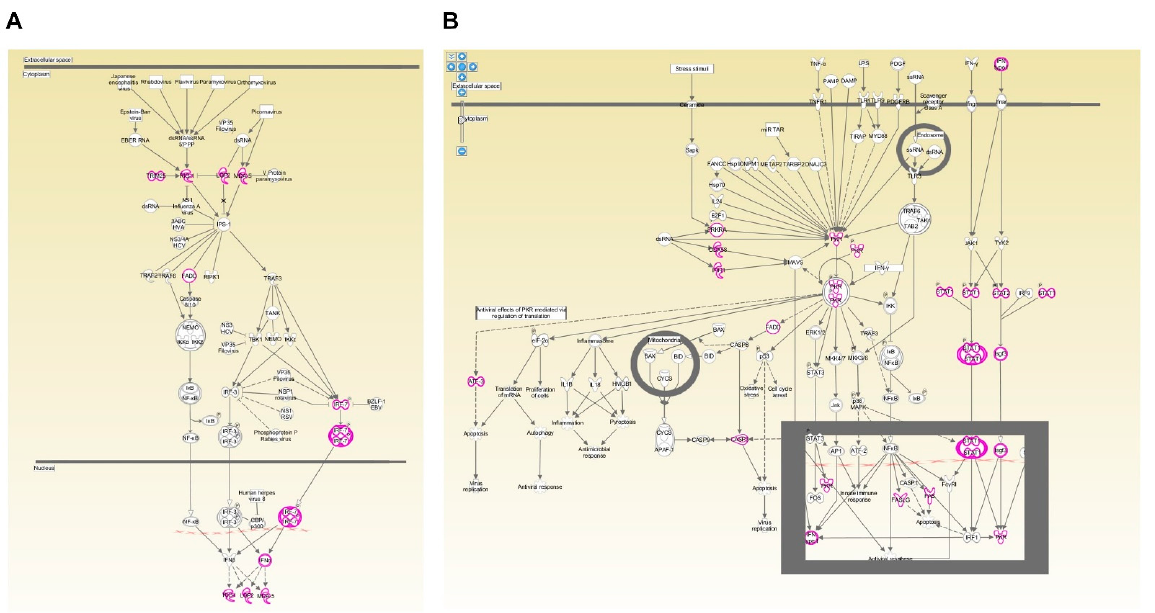
Figure A5. Canonical pathways identified by functional analysis on IPA. Two canonical pathways associated with DEGs upregulated upon I-TBEV treatment are shown: “Role of RLRs in antiviral innate immunity” ( A ) and “Role of PKR in interferon induction and antiviral response” ( B ). DEGs identified by the RNA-Seq are highlighted.